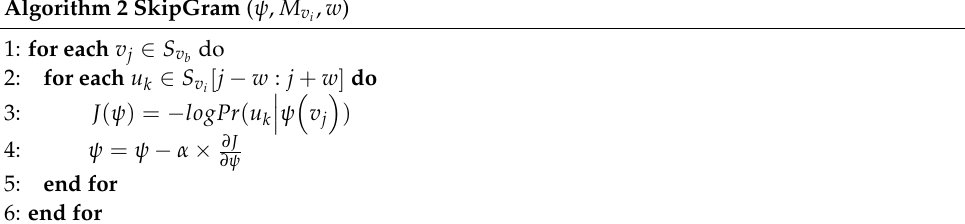
Algorithm 2 SkipGram ( ψ , M v